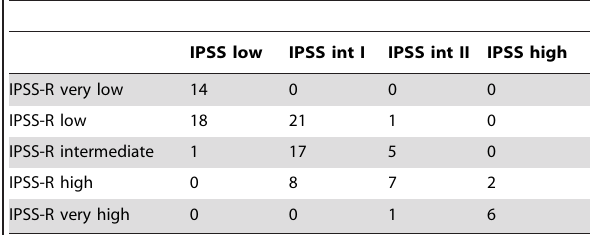
Table 3. Changes in risk category of the patients after reclassification by IPSS-R.